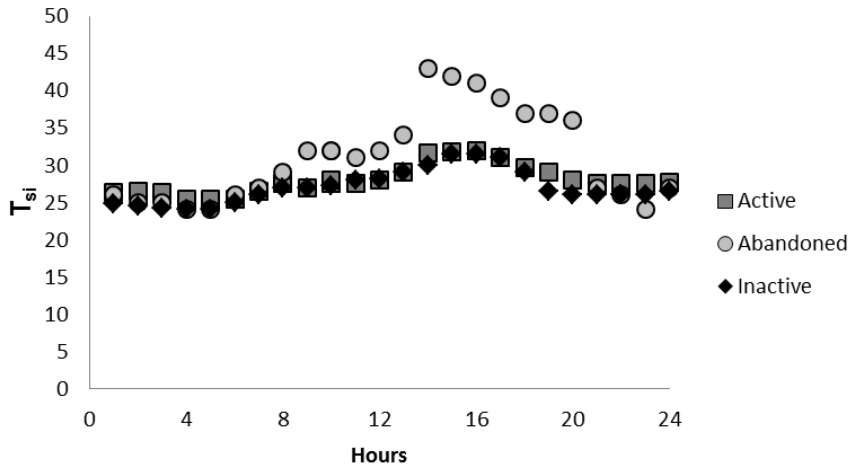
Figure 5. Temporal variation of temperature. T makes reference to temperature of substrate, squares in- si dicate active burrows, circles make reference to abandoned burrows and rhombus show inactive